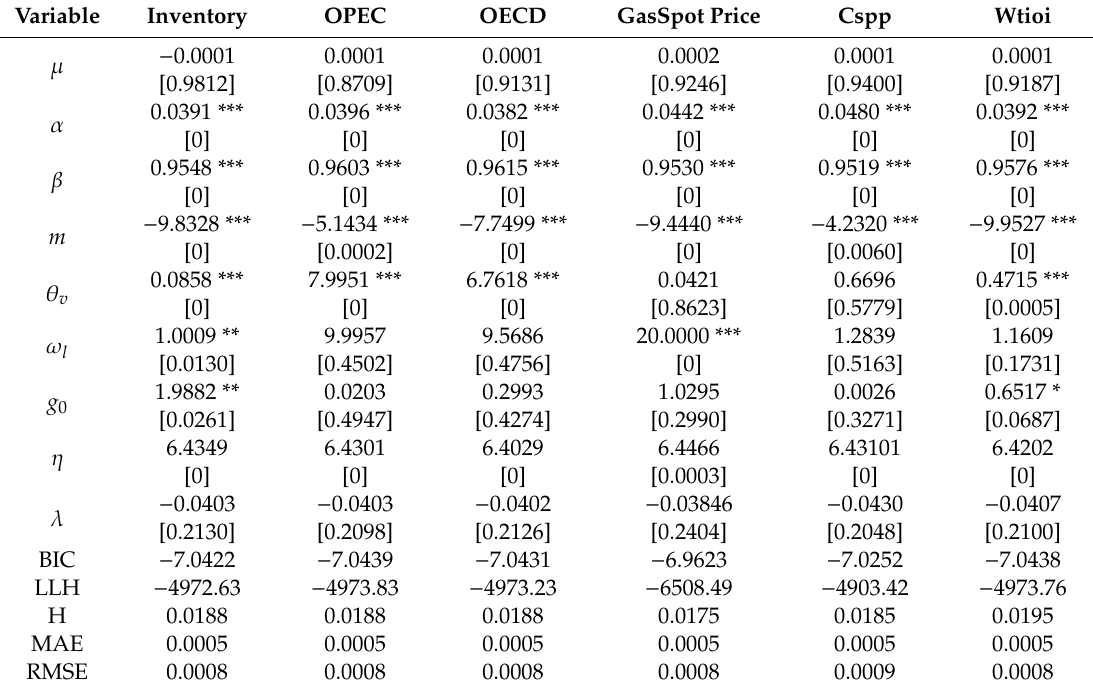
Table 5. Estimation results of low-frequency and single-factor fluctuation e ff